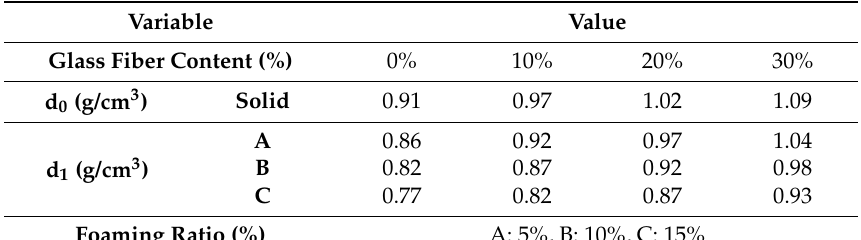
Table 1. Results based on foaming ratio equation.